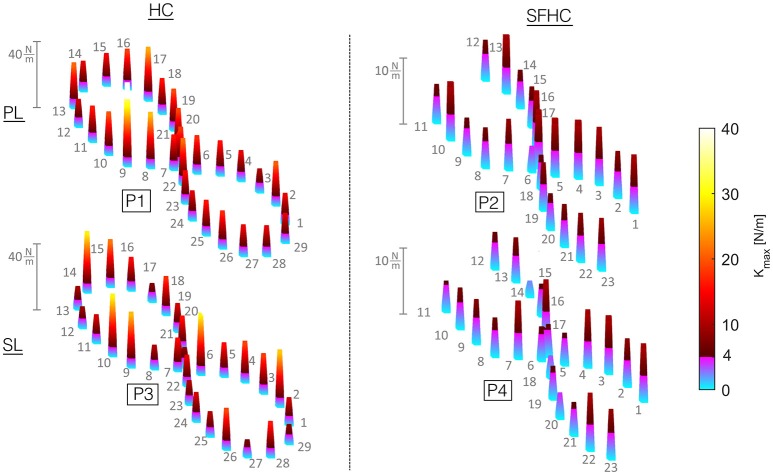
Maximal stiffness Kmax from all the users and trials in each point along the trajectory is presented: the height and color of each column indicates the corresponding point median. To account for the difference in terms of median values from experiments PL1 and SL1 compared with PL2 and SL2, a custom color-map was designed. Kmax values from 0 to 4 N/m are plotted with colors from light blue to purple, while Kmax values from 4 to 40 N/m range from a dark red to bright yellow.